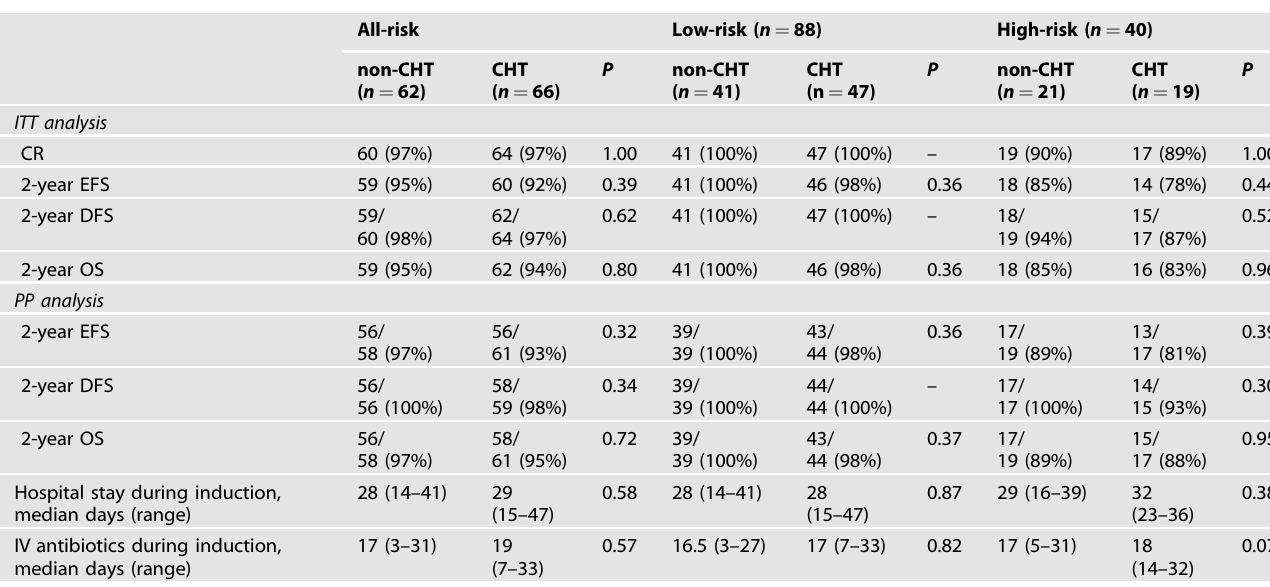
Table 2. Clinical